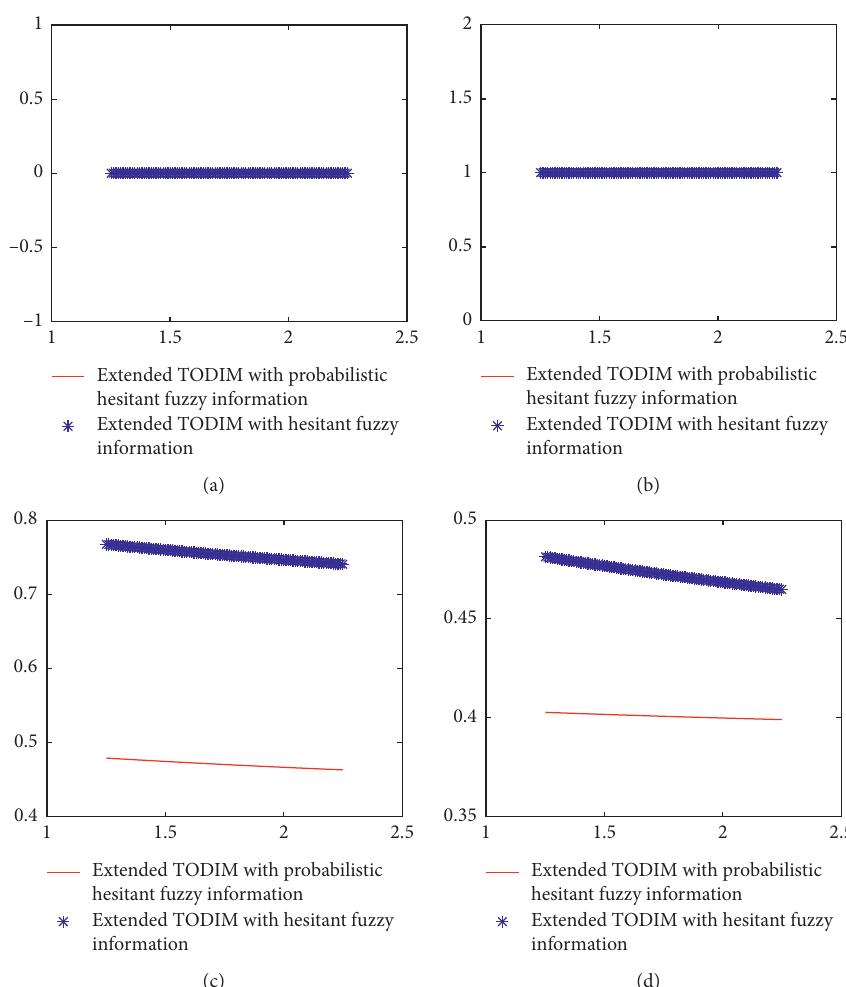
Figure 9: Sensitivity analysis of extended TODIM by changing λ . 1 . 25 ≤ λ ≤ 2 . 25, α � β � 0 . 88, c � 0 . 61, and δ � 0 . 69. (a) A